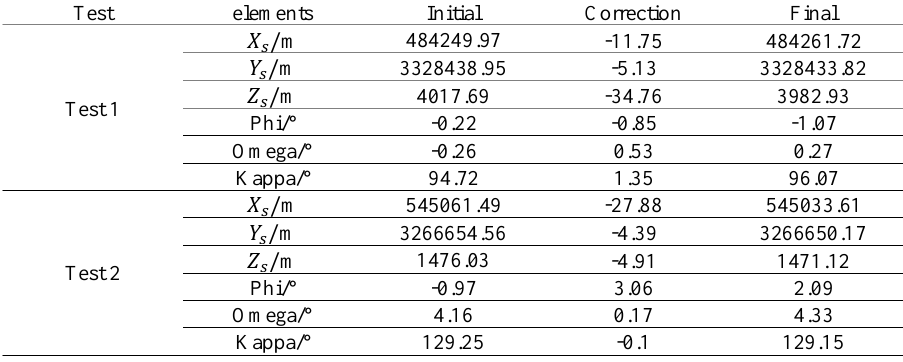
Table 3. Optimization of exterior orientation elements